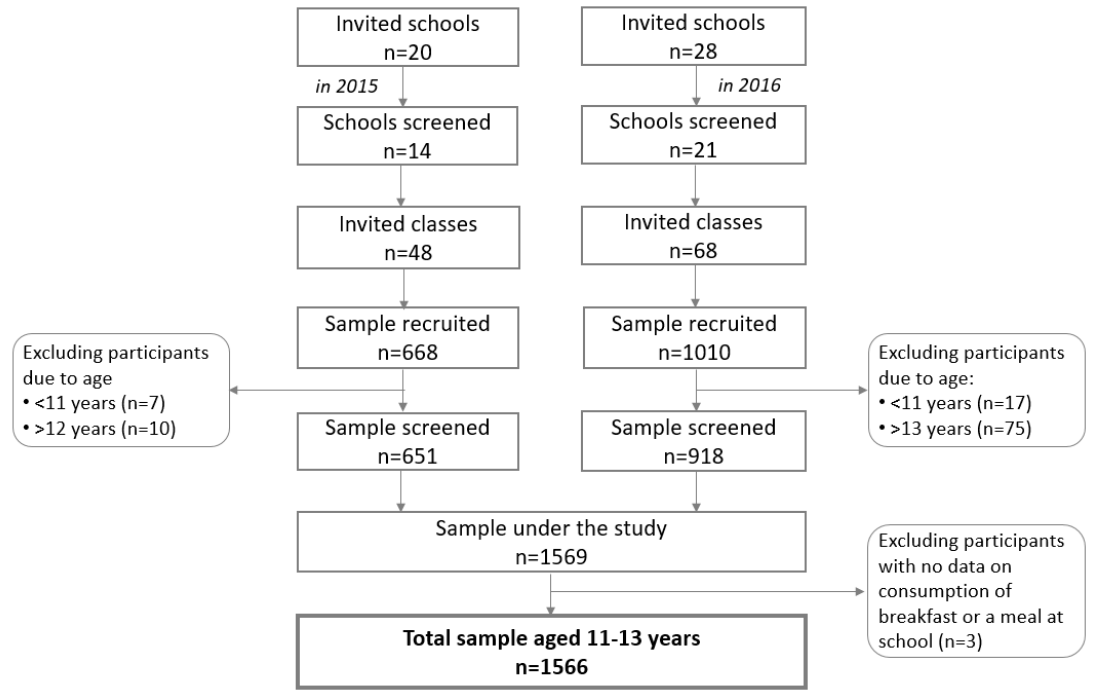
Figure 1. Sample collection.